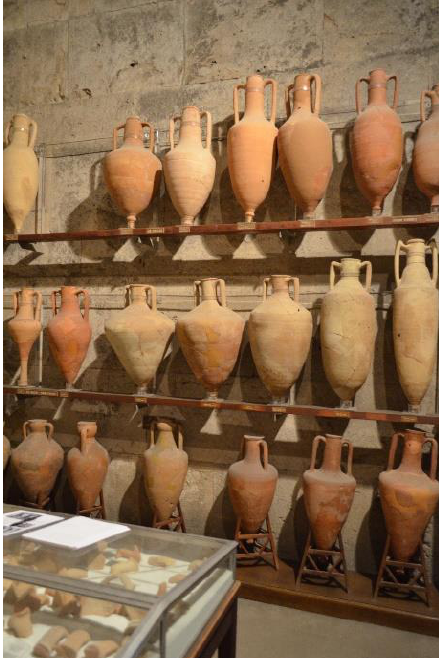
Figure 1: The amphorae shop in the Agora